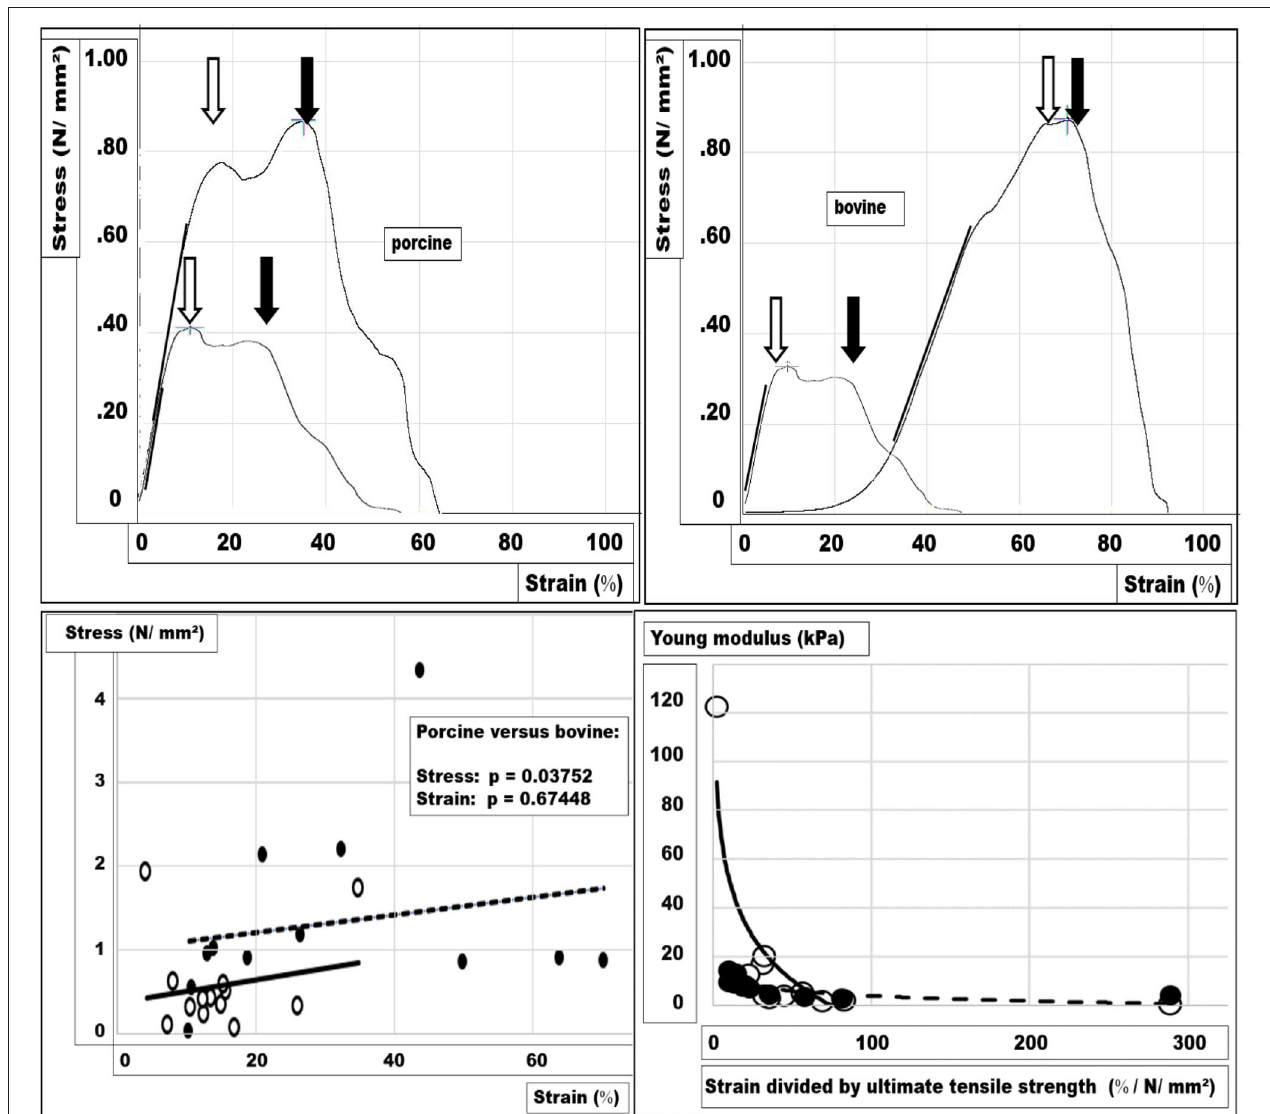
FIGURE 1 | Stress-strain relations were analyzed with the TA. Examples of the stress-strain relations for porcine (left) and bovine tissues (right) are depicted in the upper panel. In both panels, two peaks are marked with arrows indicating a ductile failure pattern. A cross marks the load-bearing capacity at the higher peak. In addition, the line used for the calculation of the stiffness is indicated on the upper panels as a thicker straight line fitted by eye to the curves. In the lower-left panel, the ultimate tensile strength is given for each sample of both tissues (dots = bovine, circles = porcine) as a function of its respective strain at the breaking point. In the lower right panel, the modules describing the mechanical tissue compliance are depicted for both tissues (dots = bovine, circles = porcine). In the lower panels, the trend lines are indicated for porcine (solid) and bovine (broken) tissue. As a trend, the bovine tissue has more tensile strength, whereas porcine tissue is less distensible (lower left panel) . At a higher stiffness, the tissues are less distensible normalized for 1 N/mm ² . Porcine tissue stretches less when 1 N/mm ² stress is applied, whereas bovine tissue is more compliant (lower right panel)